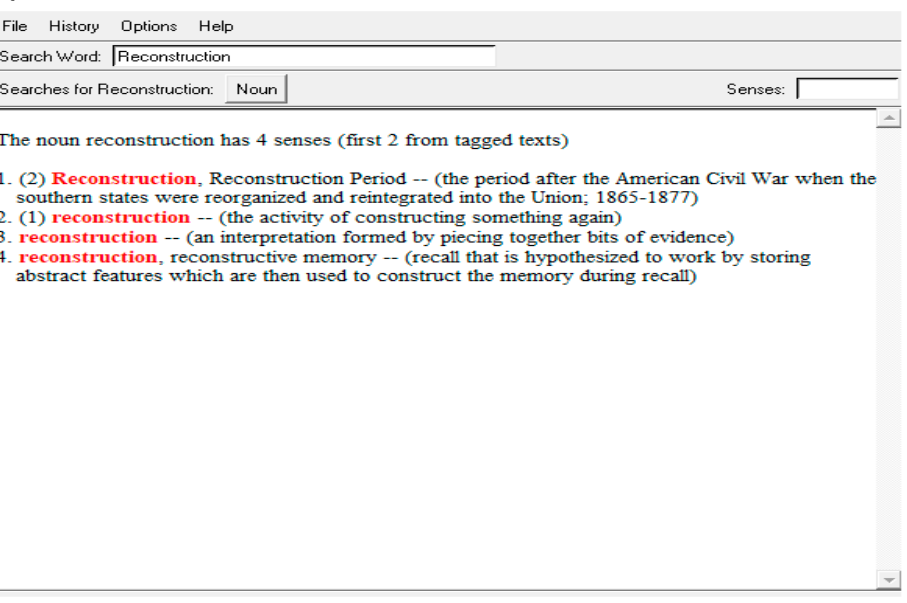
Figure 3. The Synonyms of Reconstruction process using the WordNet2 technique.